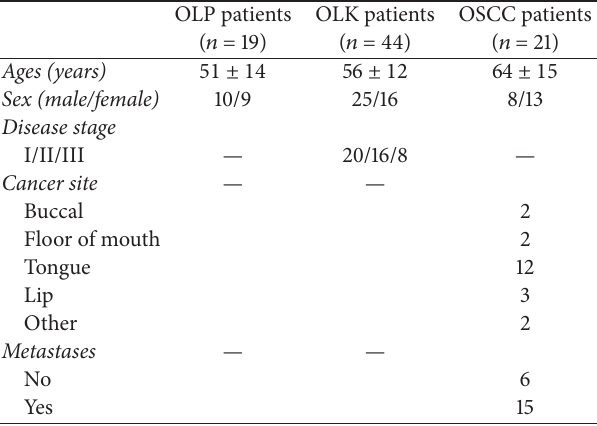
Table 1: Patient and control